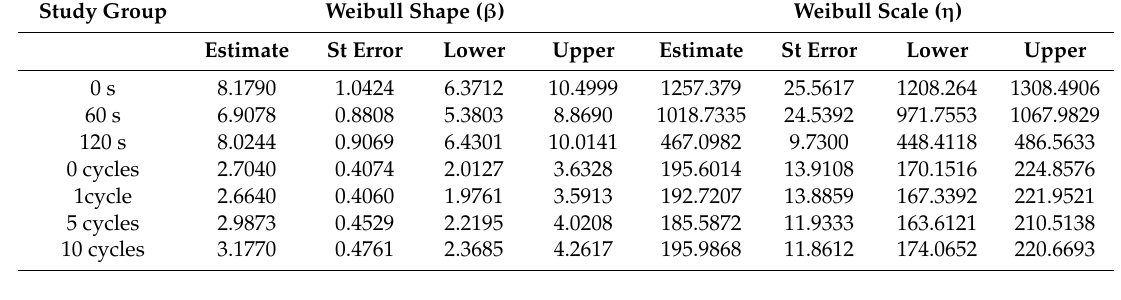
Table 4. Weibull statistics of the number of cycles to failure for the time of use and sterilization cycles study groups.